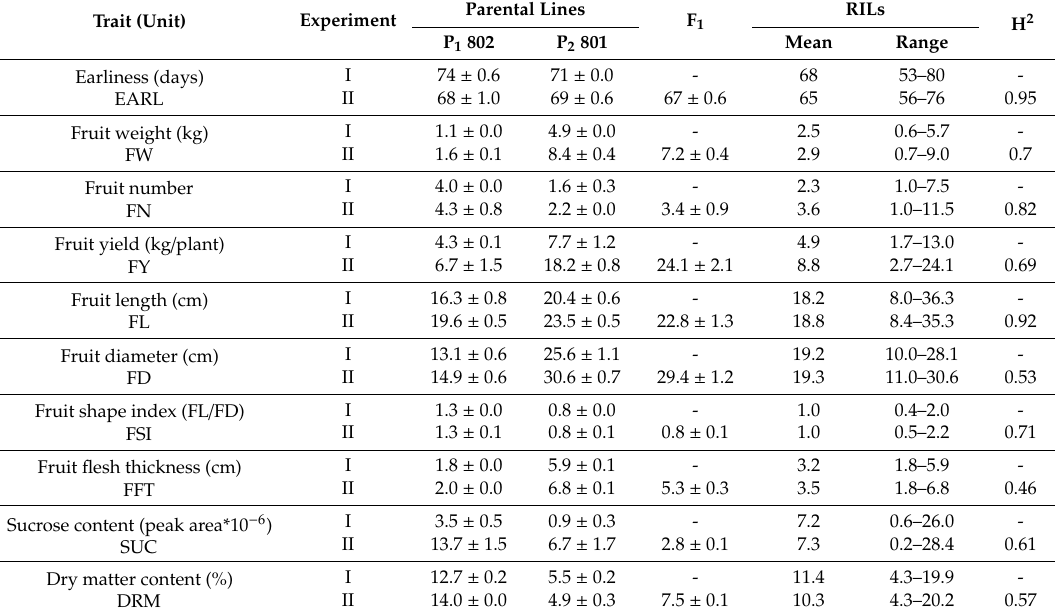
Table 1. Summary of the trait evaluation for parental lines P 1 802 and P 2 801, and F 1 and 92 F 6 recombinant inbred lines (RILs) in 2013 and 2014 (experiments I and II). Mean values, standard deviation, minimum and maximum values and broad sense heritability value (H 2 ) are